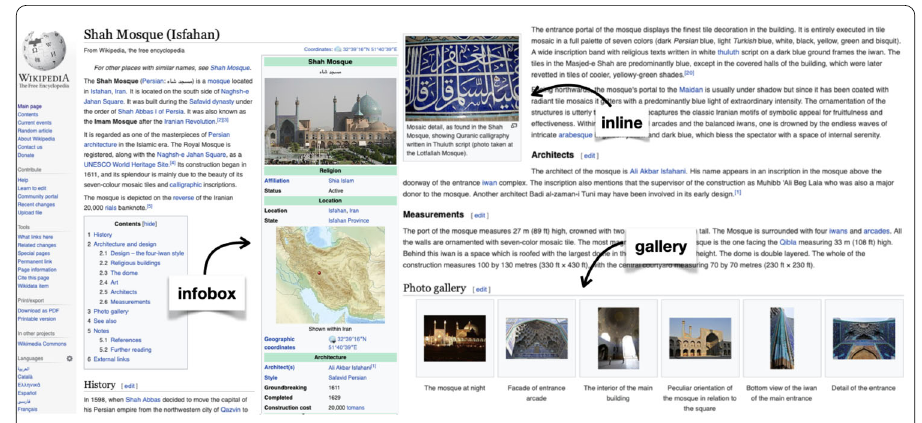
Figure 2 Examples of the three types of positions ( infobox , inline , and gallery ) of images within a Wikipedia